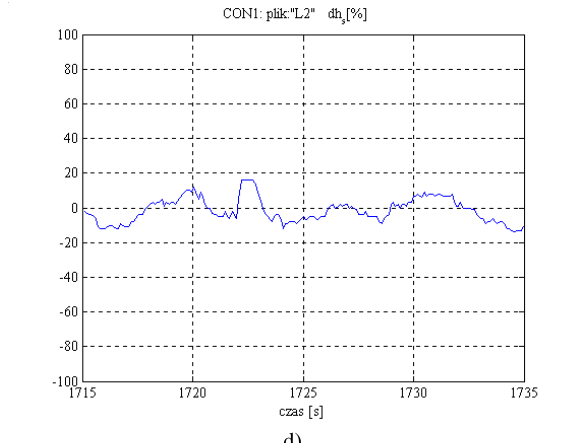
Fig 5. Selected flight parameters with q measurement defect when stabilizing flight altitude; left side – before reconfi- guration, right side – after reconfiguration; a), b) pitch rate changes q [°/s], c), d) movements of flying controls